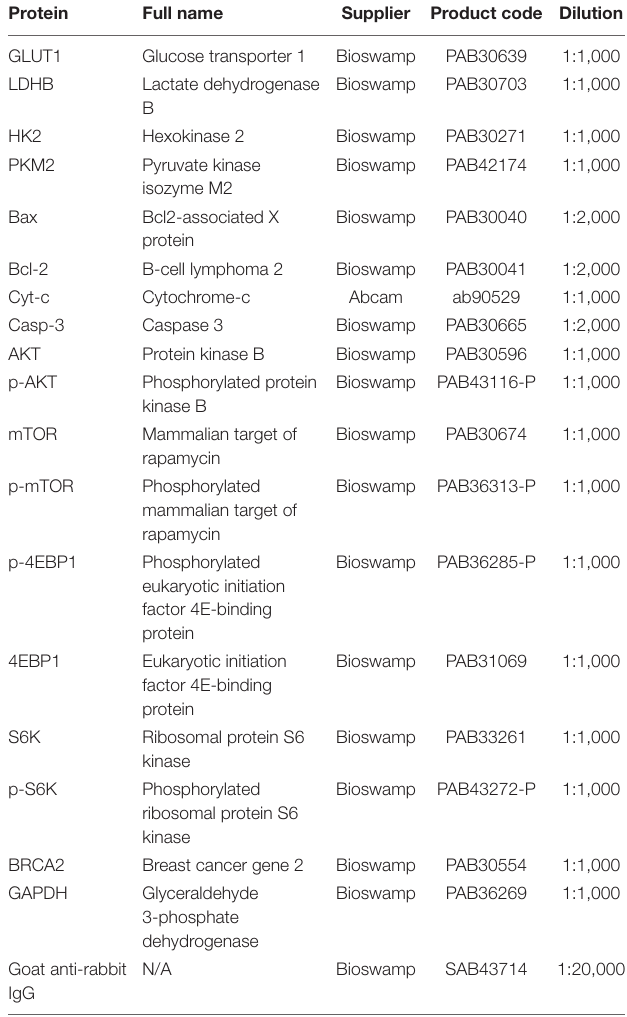
TABLE 2 | Antibodies for western